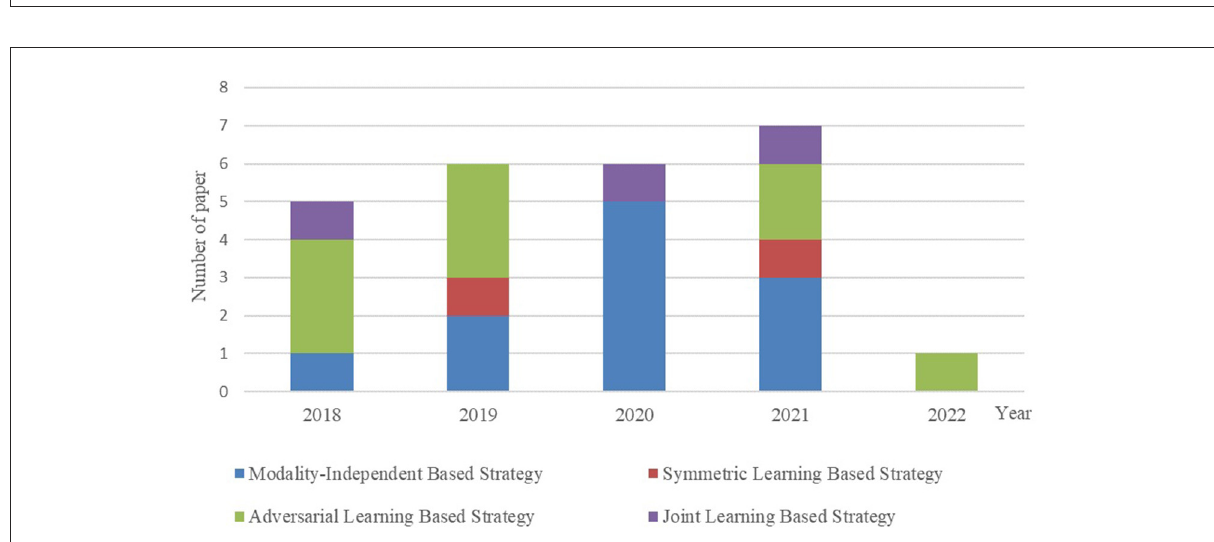
FIGURE5 Contrast bar graph of the number of publications on the four strategies for the GAN-based biomedical image registration over the last 5 years from 2018–2022.